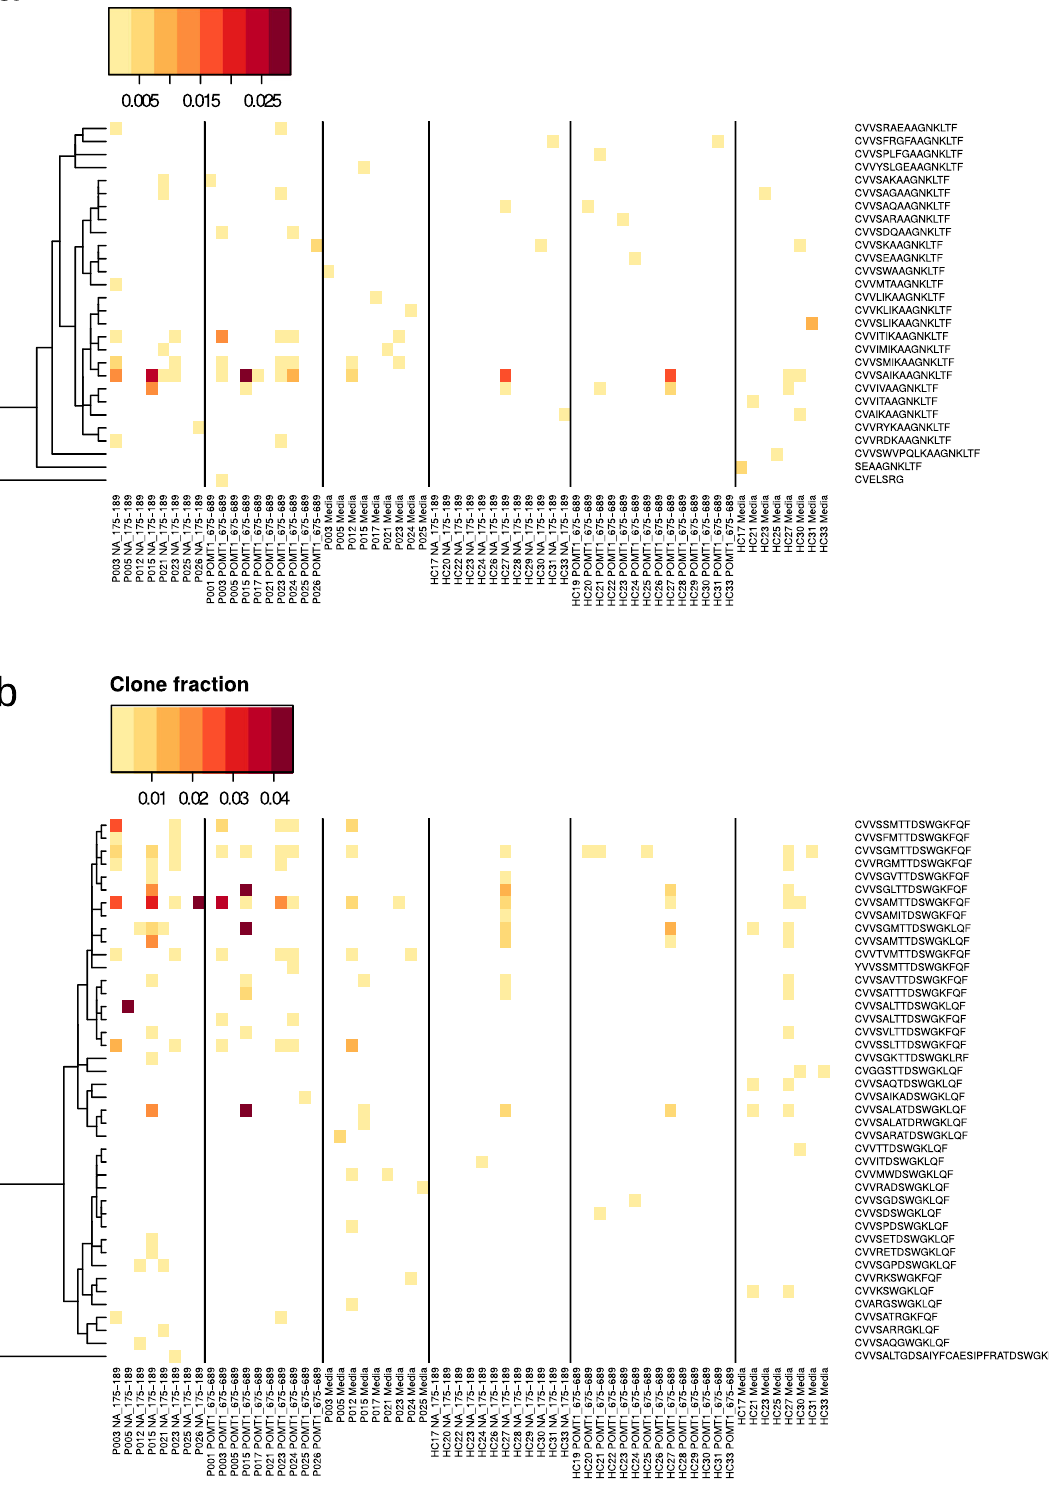
Fig. 9 T cell clones using TRAV10 – TRAJ17 and TRAV10 – TRAJ24 gene segments. TCR α chains (TRA) were sequenced from the same RNA samples as used for RNA sequencing (compare Fig. 8). P: patient; HC: healthy control. Heatmaps present clone fractions, i.e. the proportions of clones using TRAV10 – TRAJ17 ( a ) and TRAV10 – TRAJ24 ( b ) of all clones in total data. Clones are clustered based on CDR3 sequence. Peptides and recombinant proteins . 15-mer peptides covering hemagglutinin muscle (50 μ l emulsion volume; male or female mice; 3 months of age), followed by (GenBank entry ACP41953.1) and neuraminidase (YP_009118627.1) of in fl uenza one booster injection after 14 days. After 6 – 9 weeks from the fi rst injection, mice (A/California/07/2009 (H1N1)), and nucleoprotein (ADE29096.1) of in fl uenza (A/ were exsanguinated by retro-orbital bleeding under ketamine/xylazine anesthesia reassortant/NYMC X-179A (California/07/2009 × NYMC X-157)(H1N1)) with 12 (Intervet International, Boxmeer, The Netherlands; Bayer HealthCare, Leverkusen, amino acid overlap were produced. 2 ×5 15-mer peptides with 12 amino acid Germany), and spleens were harvested for collection of cells. NATURE COMMUNICATIONS| (2021) 12:2283 |https://doi.org/10.1038/s41467-021-22637-8|www.nature.com/naturecommunications